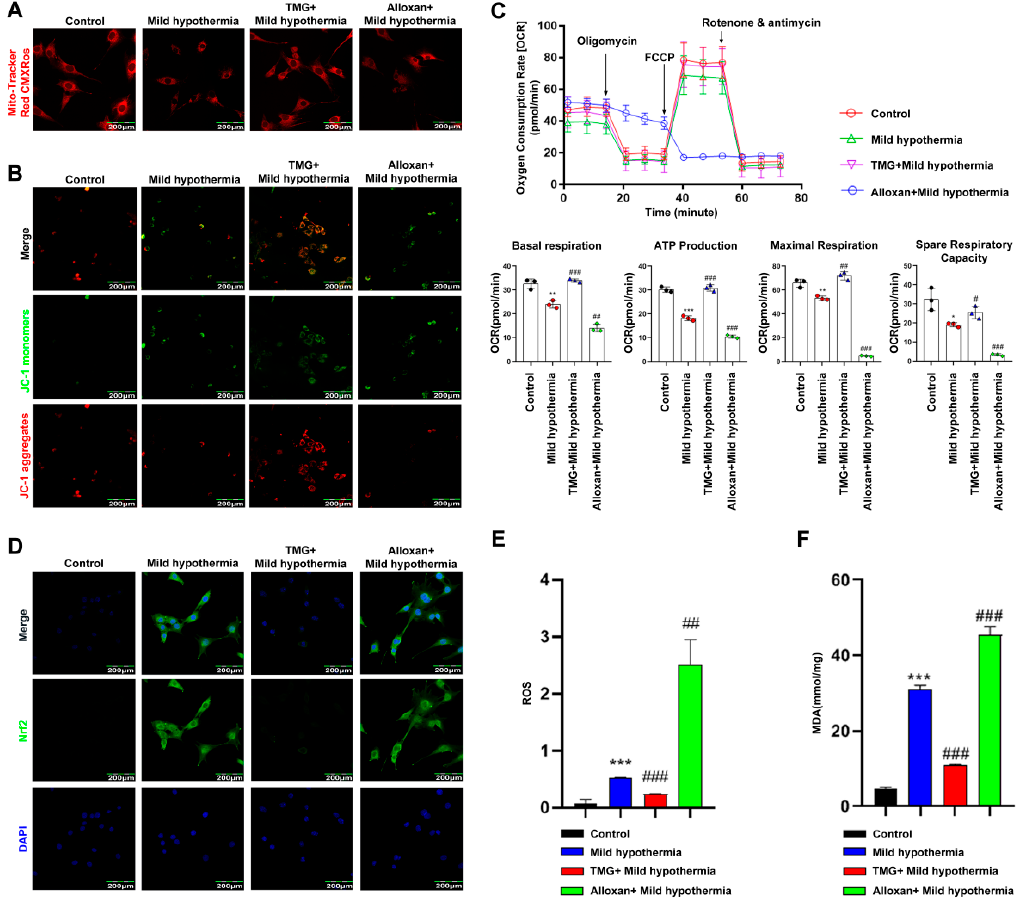
Figure 5. MHT compromises mitochondrial function. Mouse primary SM cells were isolated and cultured. After 3 h of MHT exposure at 32 ◦ C, primary SM cells were collected for functional analysis. ( A ) MitoTracker™ Red CMXRos staining of C2C12 cells. ( B ) JC-1 staining of C2C12 cells. ( C ) Mitochondrial function (i.e., basal respiration, ATP production, maximum respiration, and reserve respiratory capacity) was assessed with the cellular mitochondrial pressure test. ( D ) Nrf2 immunocytochemistry staining in C2C12 cells. ( E ) Flow cytometry analysis of ROS production in C2C12 cells. ( F ) MDA content. All results contain 3 replicates per group (n = 3/group). Data are presented as means ± sd and were analyzed by one-way ANOVA. * compared to control, * p < 0.05, ** p < 0.01, *** p < 0.001; # compared to mild hypothermia group, # p < 0.05, ## p < 0.01, ### p < 0.001.